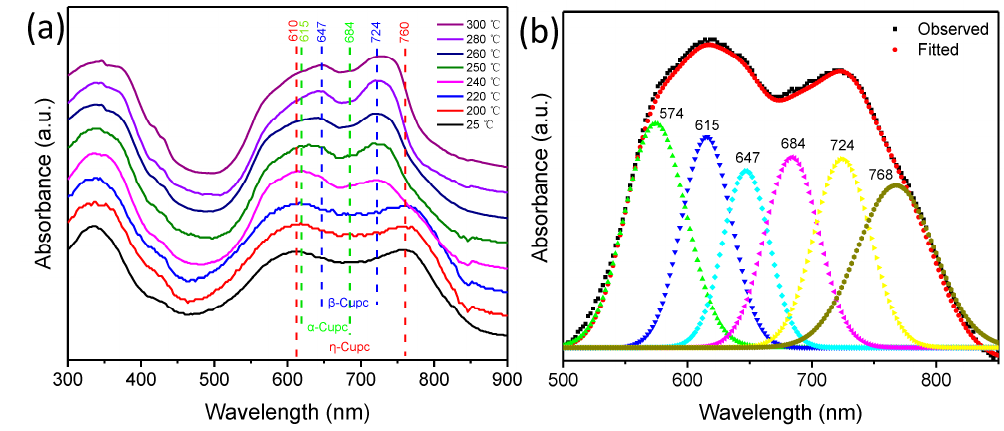
Figure 8. ( a ) UV-VIS spectra of CuPc crystals annealed at different temperatures; and ( b ) observed and fitted spectra for CuPc crystals annealed at 240 °C in the visible region.